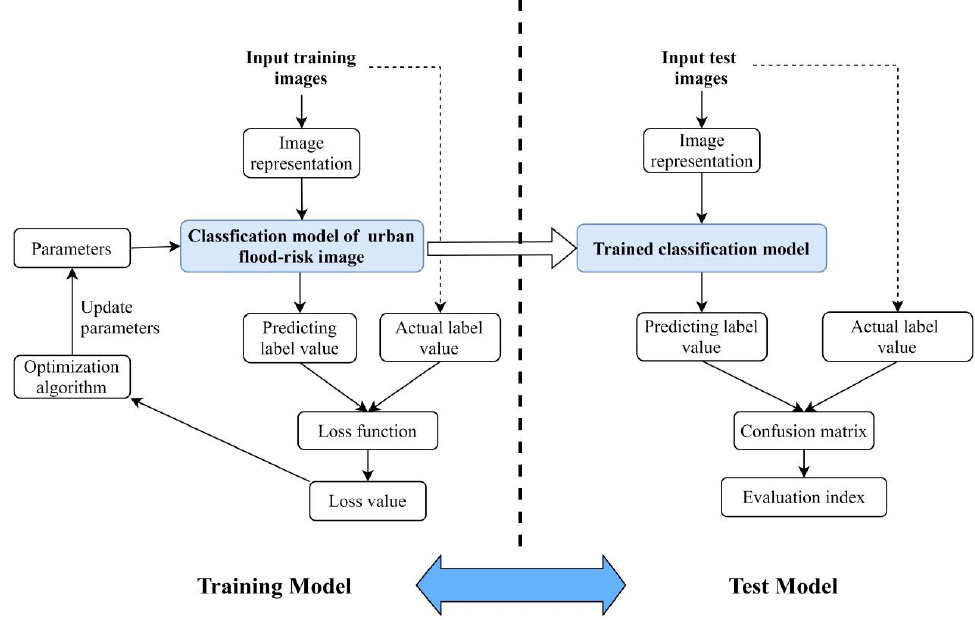
Figure 1. Processes of classi fi er design and decision-making.